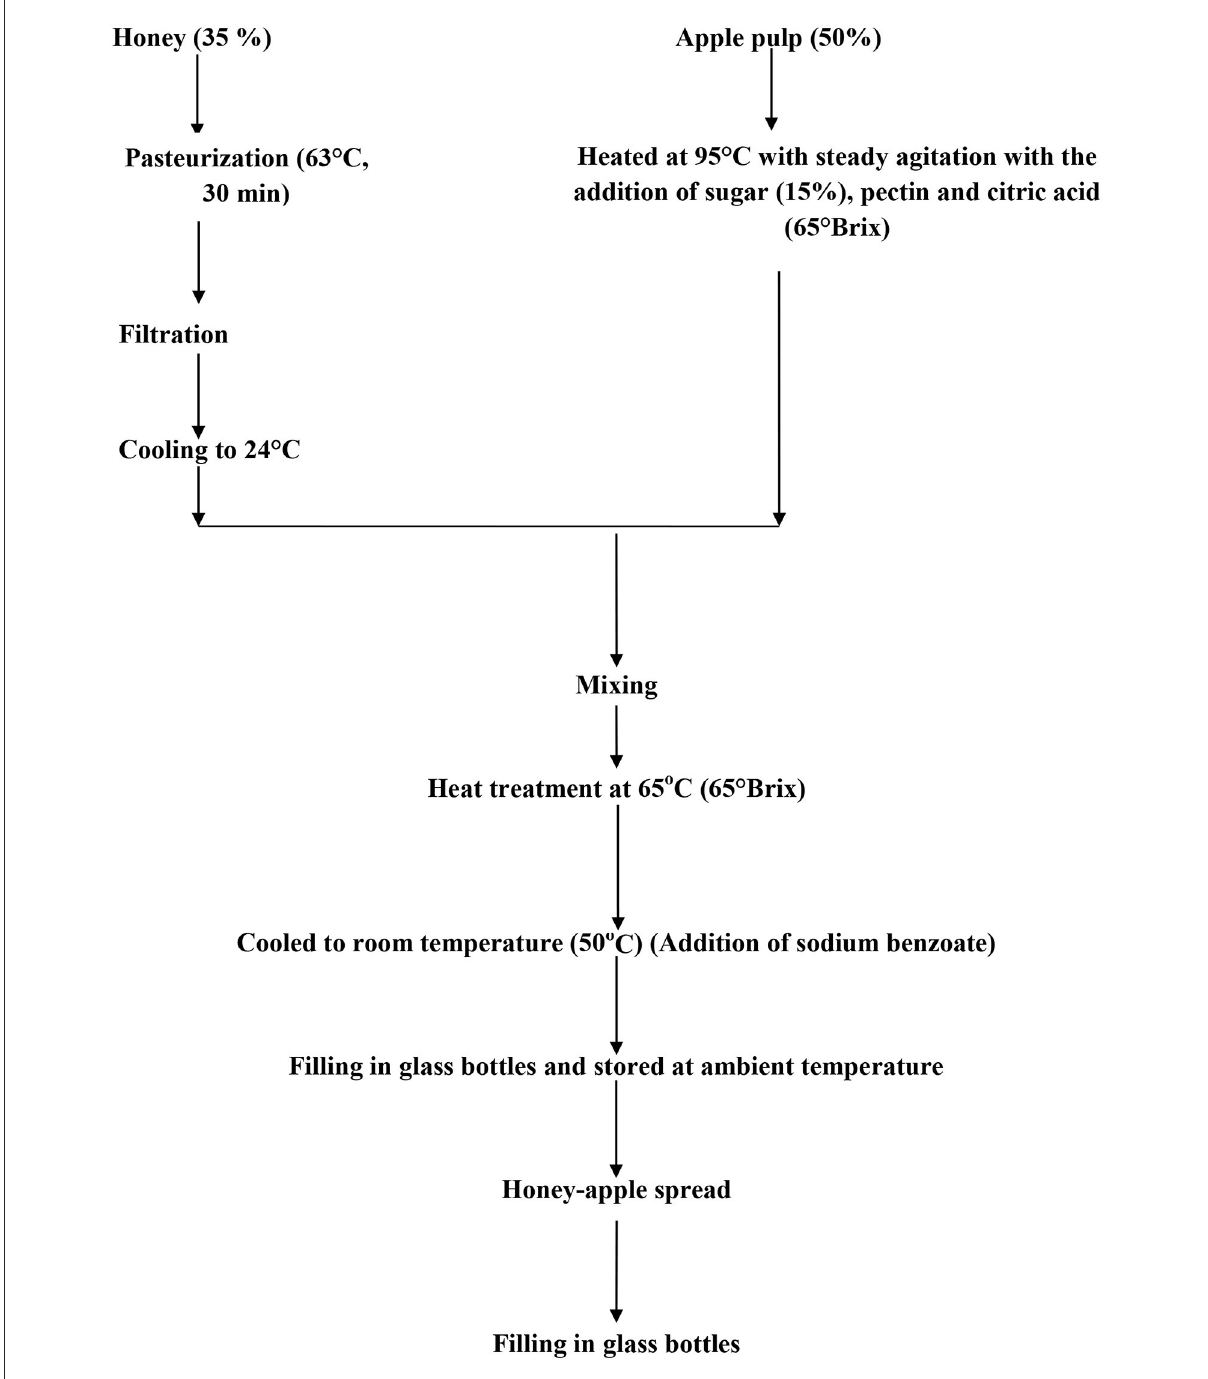
FIGURE1 Pollen grains from MF, PR, and RSA honey under